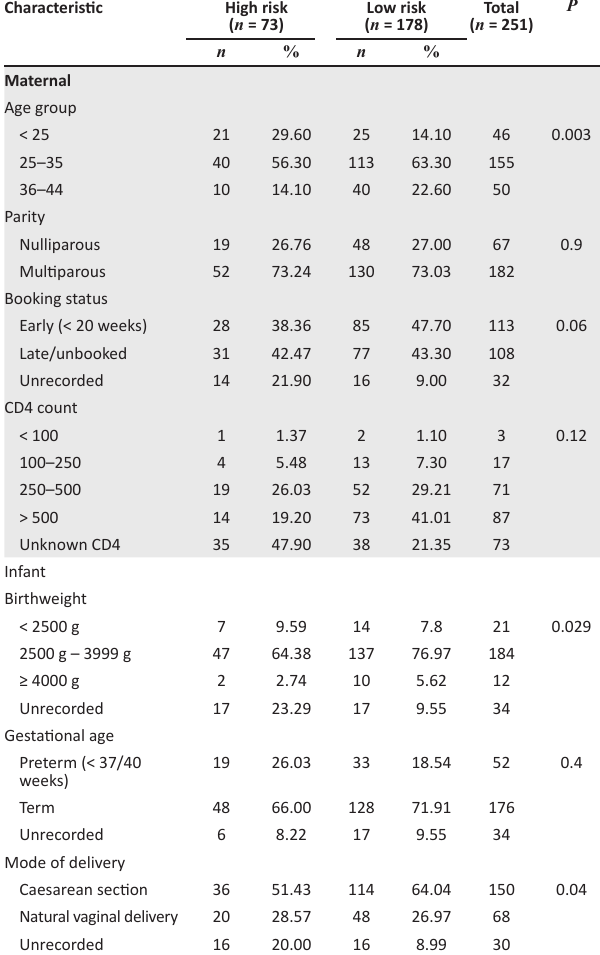
TABLE 1: Description of maternal and infant characteristics. Characteristic